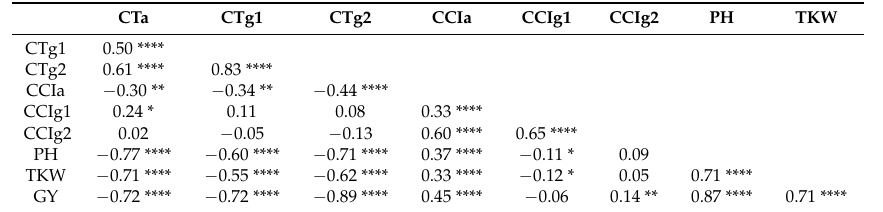
Table 3. Pearson’s correlations between phenotypic traits measured in DH population from UI Platinum/SY Capstone over four environments.